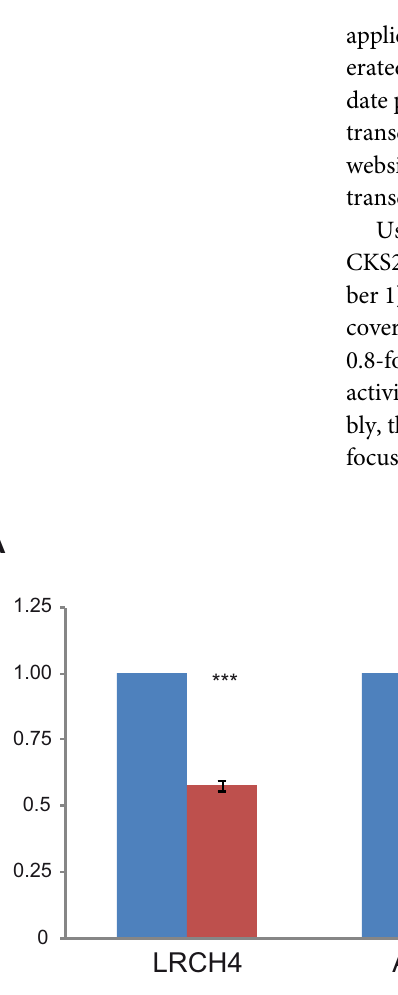
Z-scores by shuffling each promoter sequence 100 times (see Methods).